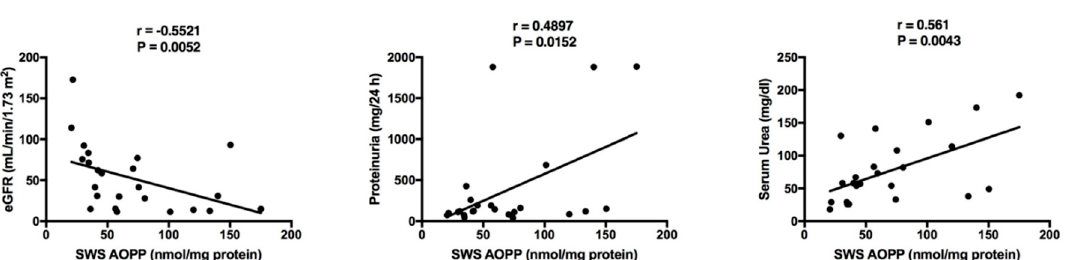
Figure 5. Correlations between salivary advanced oxidation protein products (AOPP) and clinical parameters in children with chronic kidney disease (CKD). eGFR, estimated glomerular filtration rate using Schwartz formula; SWS, stimulated whole saliva.